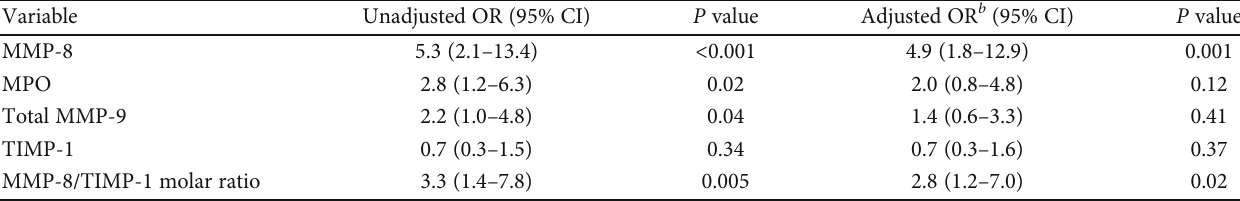
(a) Odds ratios for death